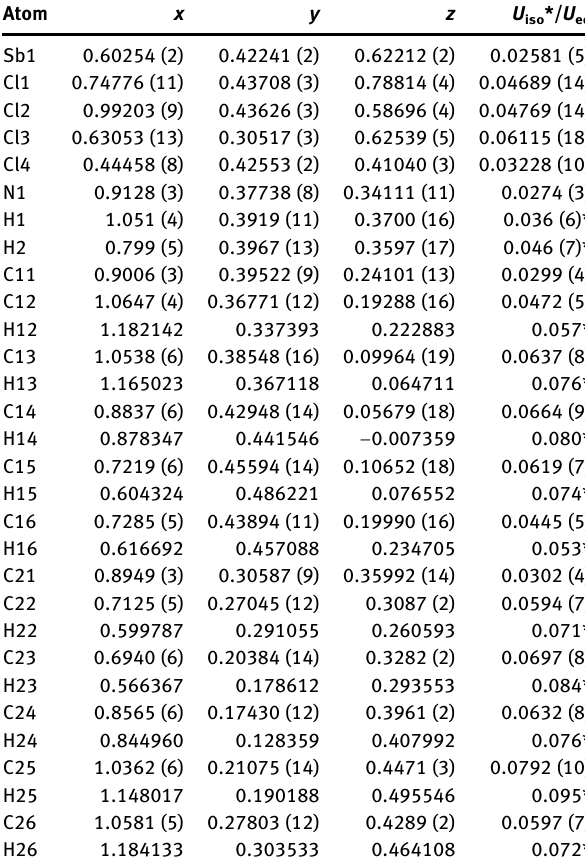
Table  : Fractional atomic coordinates and isotropic or equivalent isotropic displacement parameters (Å  ).